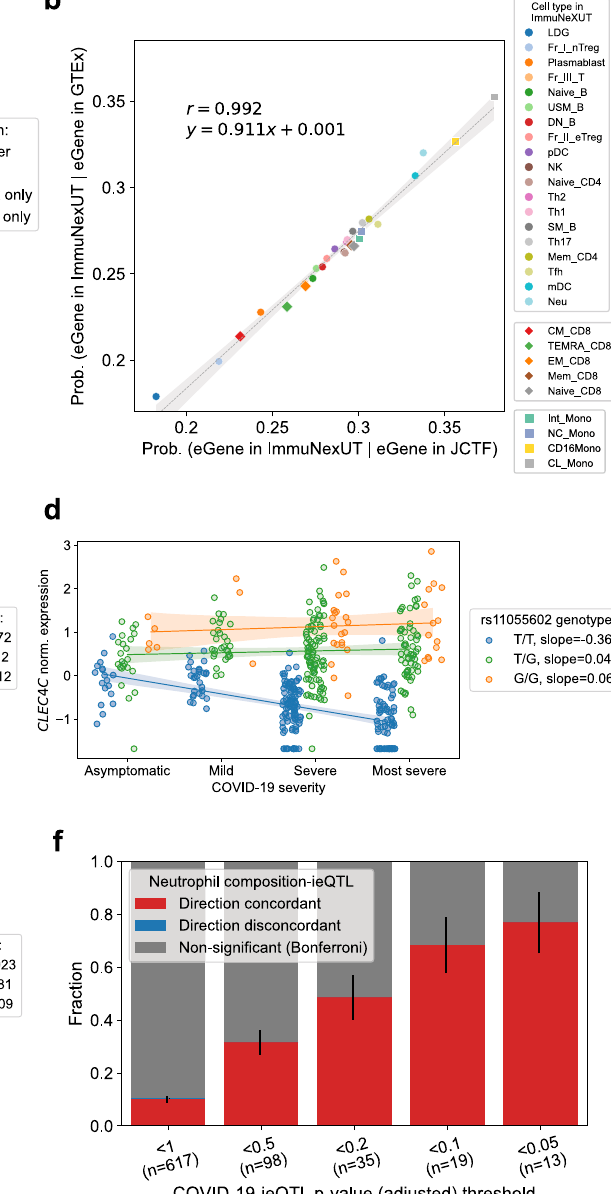
Fig. 7 | The effect of COVID-19 phenotype on transcriptional regulation land- scape. a The fraction of genes that are identi fi ed as eGenes only in our analysis (orange)orinGTEx(cyan)( y -axis),both(brown)orneither(gray),forasetofgenes withdifferentlevelsofdifferentialexpression( x -axis). b Scatterplotpresentingthe proportion of eGenes ( p <5.0×10 − 8 ) identi fi ed either in whole blood RNA-seq